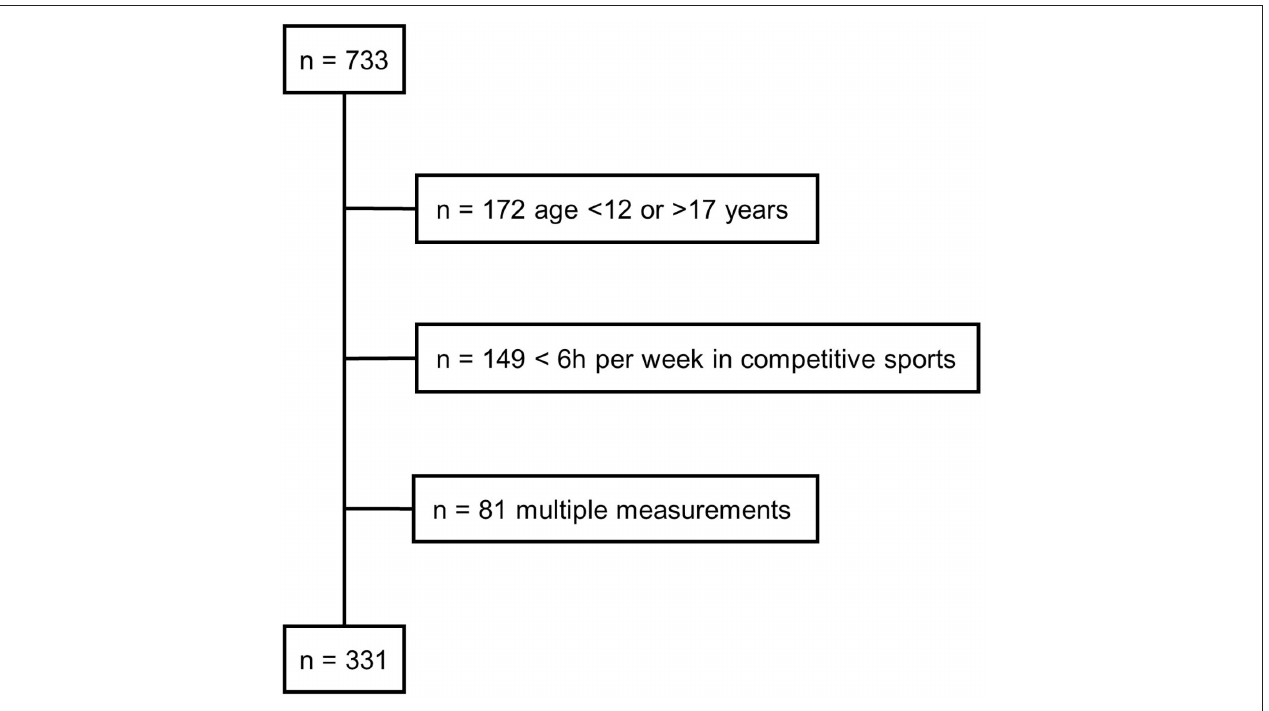
FIGURE 1 | Flowchart of inclusion and exclusion of study subjects.